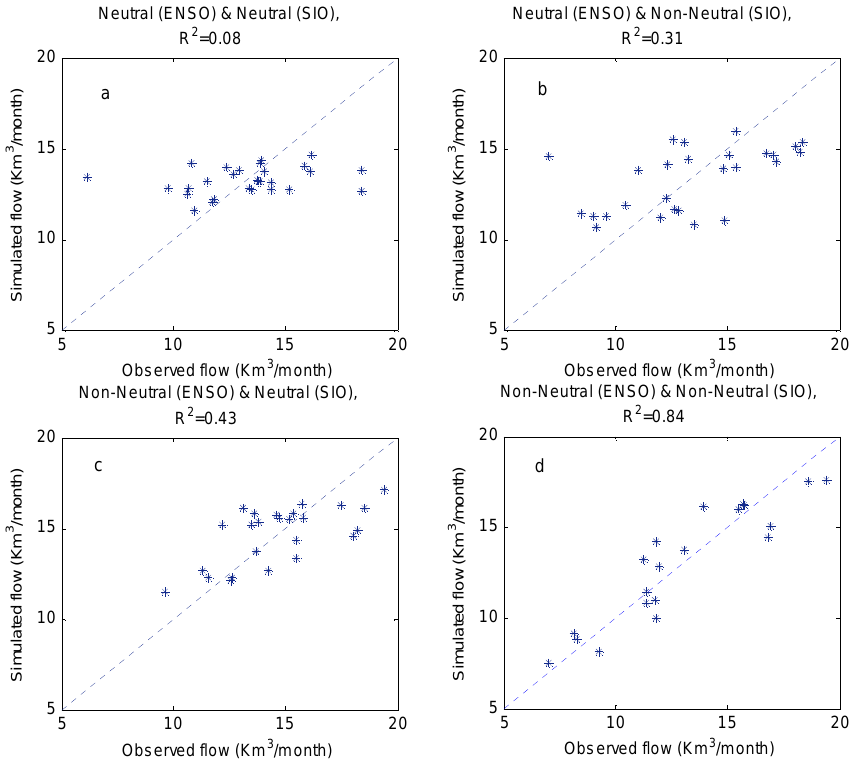
Figure 5. A comparison between the observed and simulated Nile flow showing the different modes of variability for the period from 1900 to 2000: (a) neutral ENSO (29 events) and SIO, (b) neutral ENSO and non-neutral SSTs in SIO (26 events), (c) non-neutral ENSO and neutral SSTs in SIO (26 events) and, finally, (d) non-neutral ENSO and non-neutral SSTs in SIO (19 events).